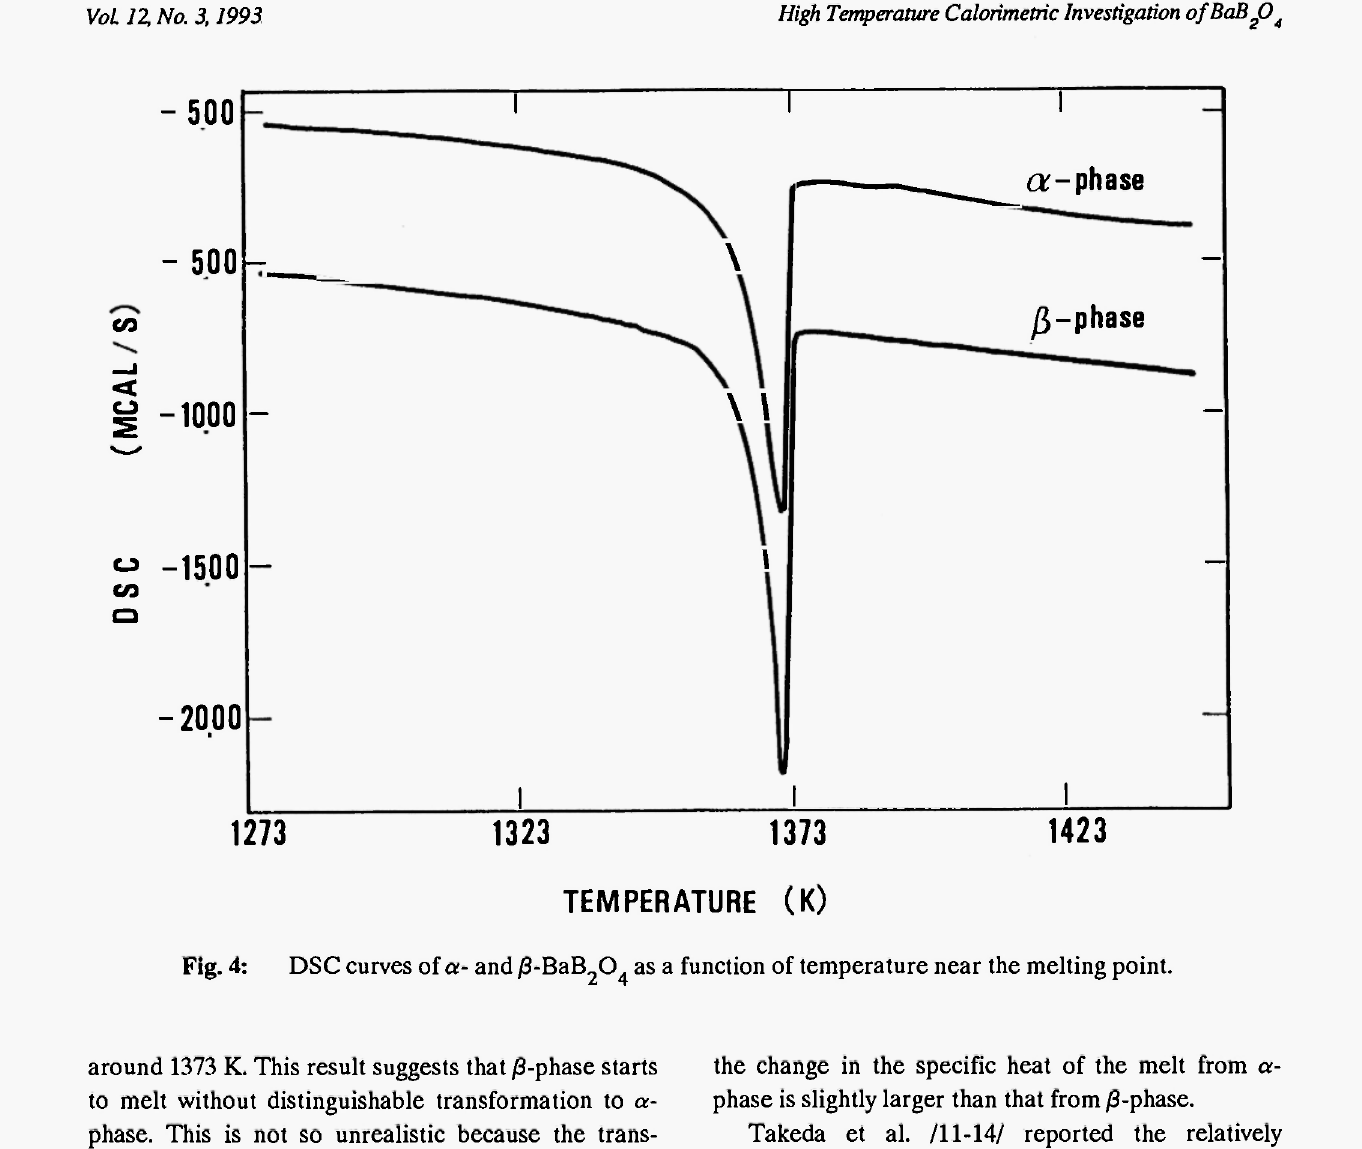
around 1373 K. This result suggests that /3-phase starts to melt without distinguishable transformation to a- phase. This is not so unrealistic because the trans- time /4/. It is, however, worth mentioning that the which corresponds to the heat of phase transforma- tion. The peak area is estimated at 28.3 J/g for α-phase